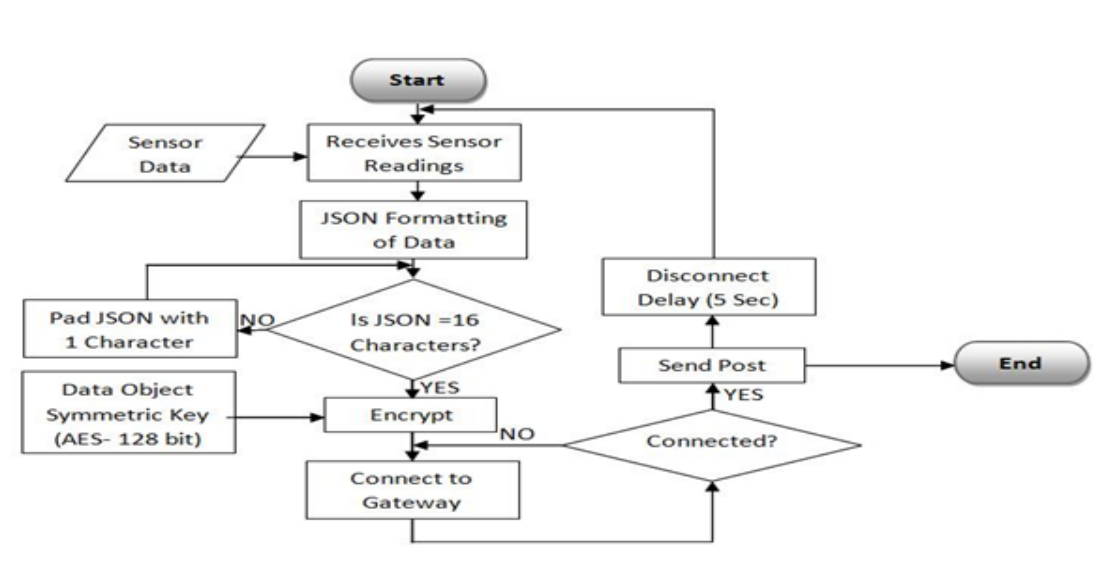
Figure 5. IoT Sensor Block Diagram